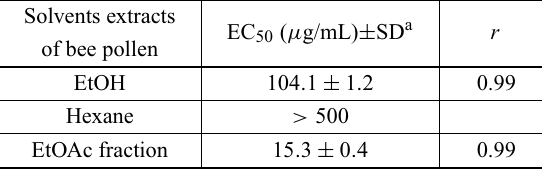
EC 50 values of different solvent extracts of pollen loads of Melipona rufiventris for free radicals scavenging, as assessed by DPPH radical-scavenging